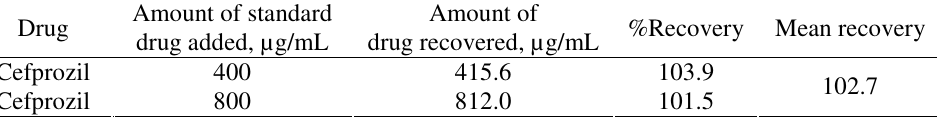
Table 3 . Results of recovery study